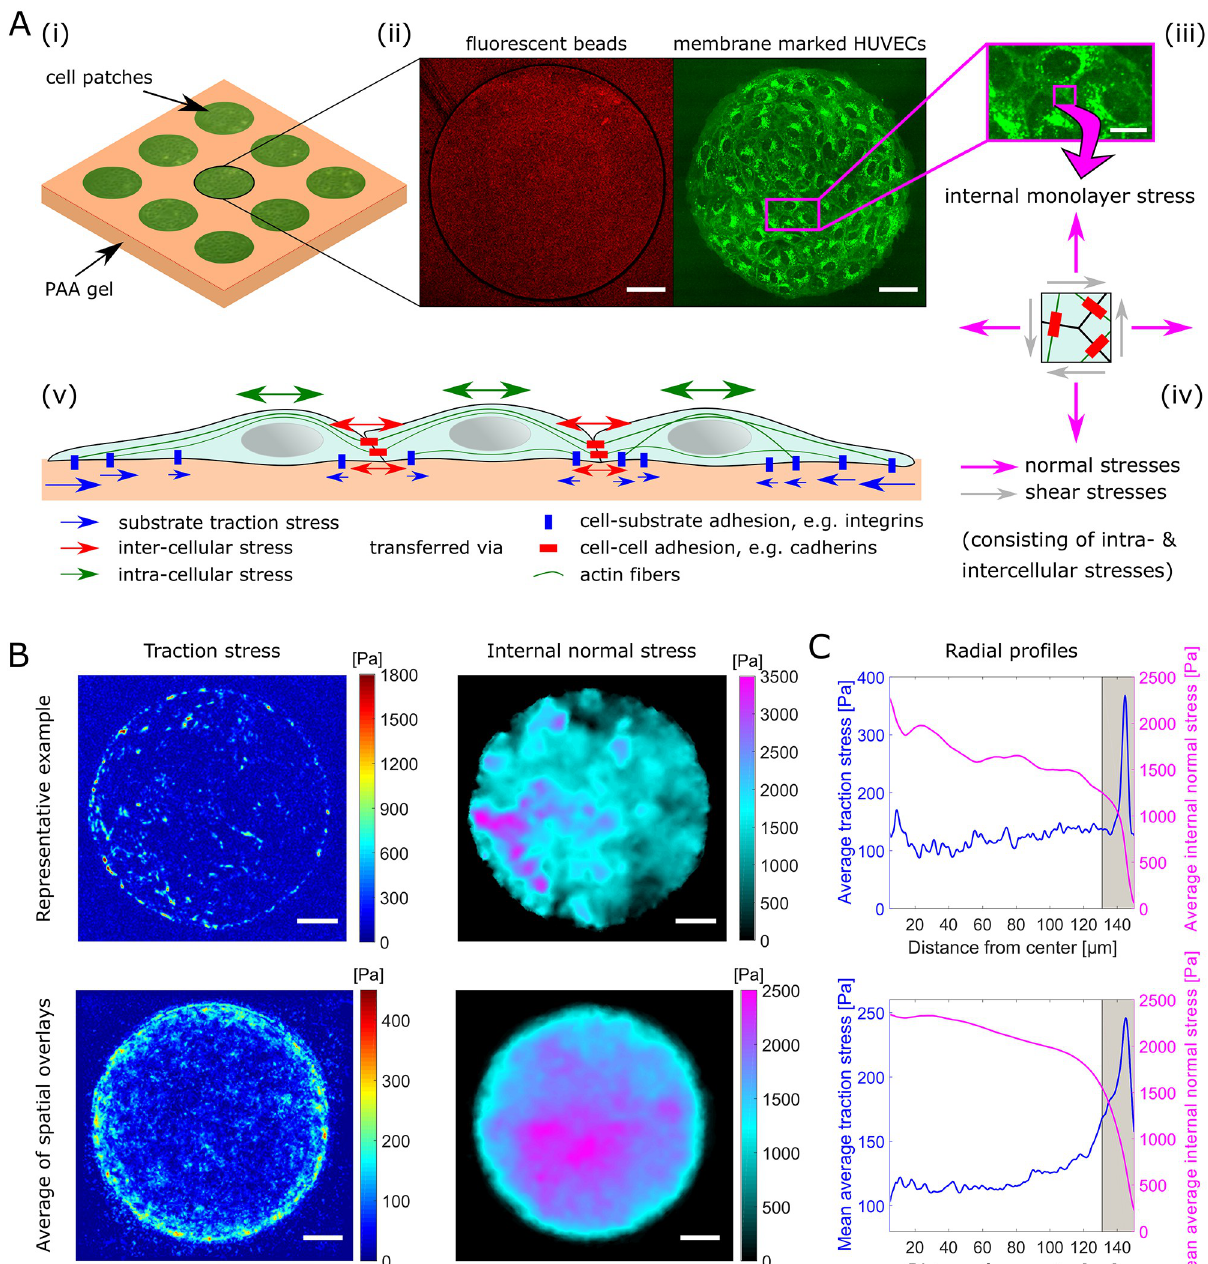
Fig 1. Experimental system and mechanical stress distributions. A : Circular islands of EC monolayers reside on ( i ) micropatterned PAA gels that ( ii ) incorporate fluorescent beads (red) close to the surface for traction force microscopy. ( iii ) Zoom in on plasma membrane stained (CellMask Deep Red) HUVECs in a monolayer patch (in ii —green). ( iv ) Normal and shear stresses act at any position within a monolayer of cells. ( v ) Schematic illustration of mechanical stress exerted and transmitted by interconnected cells. Scale bars, 50 μ m (15 μ m for zoomed-in image). B : Color-coded maps of derived traction stress and internal normal stress for a representative example monolayer patch (top) and for the spatially overlayed and averaged total of 22 different patches from 3 independent experiments (bottom). Since the spatial averaging reduces the signal-to-noise ratio in the overlayed images, a force level threshold was applied to those images prior to the averaging for better visualization. Scale bars, 50 μ m. C : Corresponding radial profiles of average traction and internal normal stress based on the data used in B (top for single example, bottom for average of multiple patches). The gray marked area indicates the approximate region of edge cells. The inner 5 μ m have been neglected here due to poor number of pixels statistics. Traction stresses are predominantly applied by cells at the edge of the monolayers, while internal normal stresses accumulate toward the center.